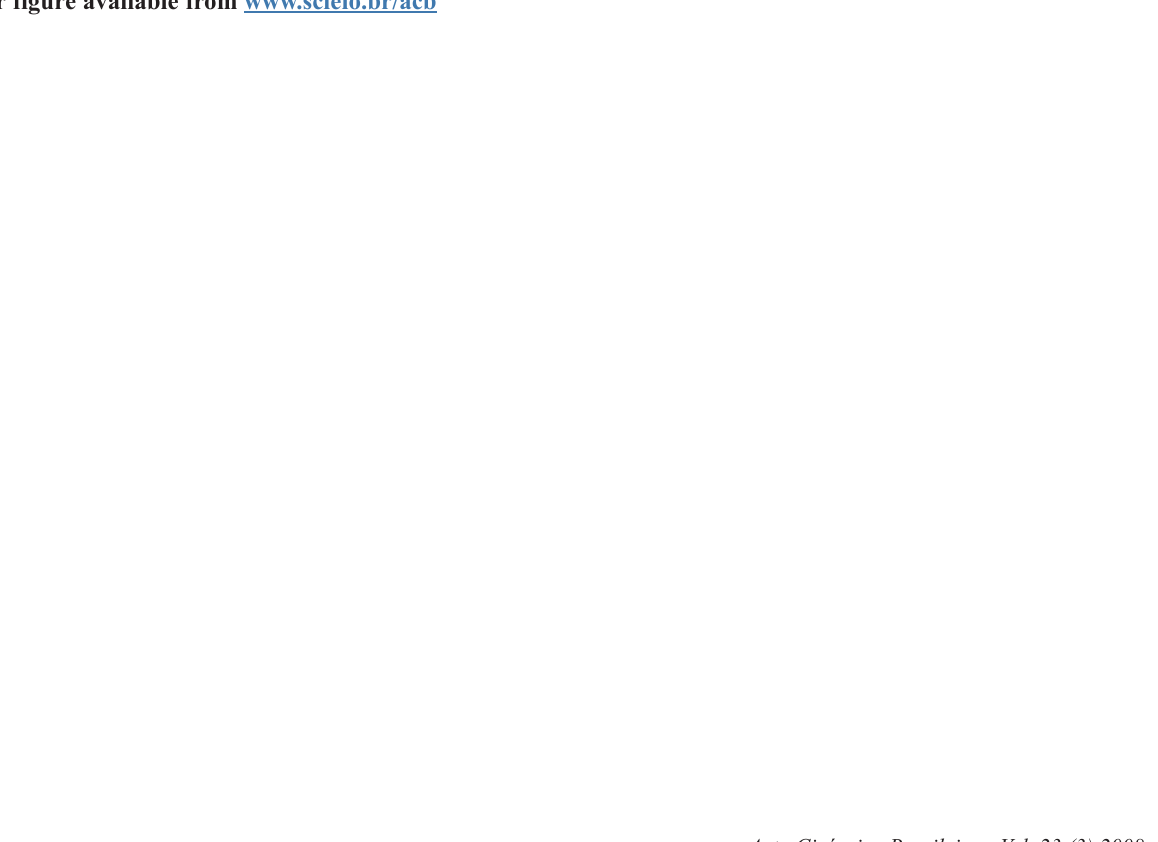
*Color figure available from